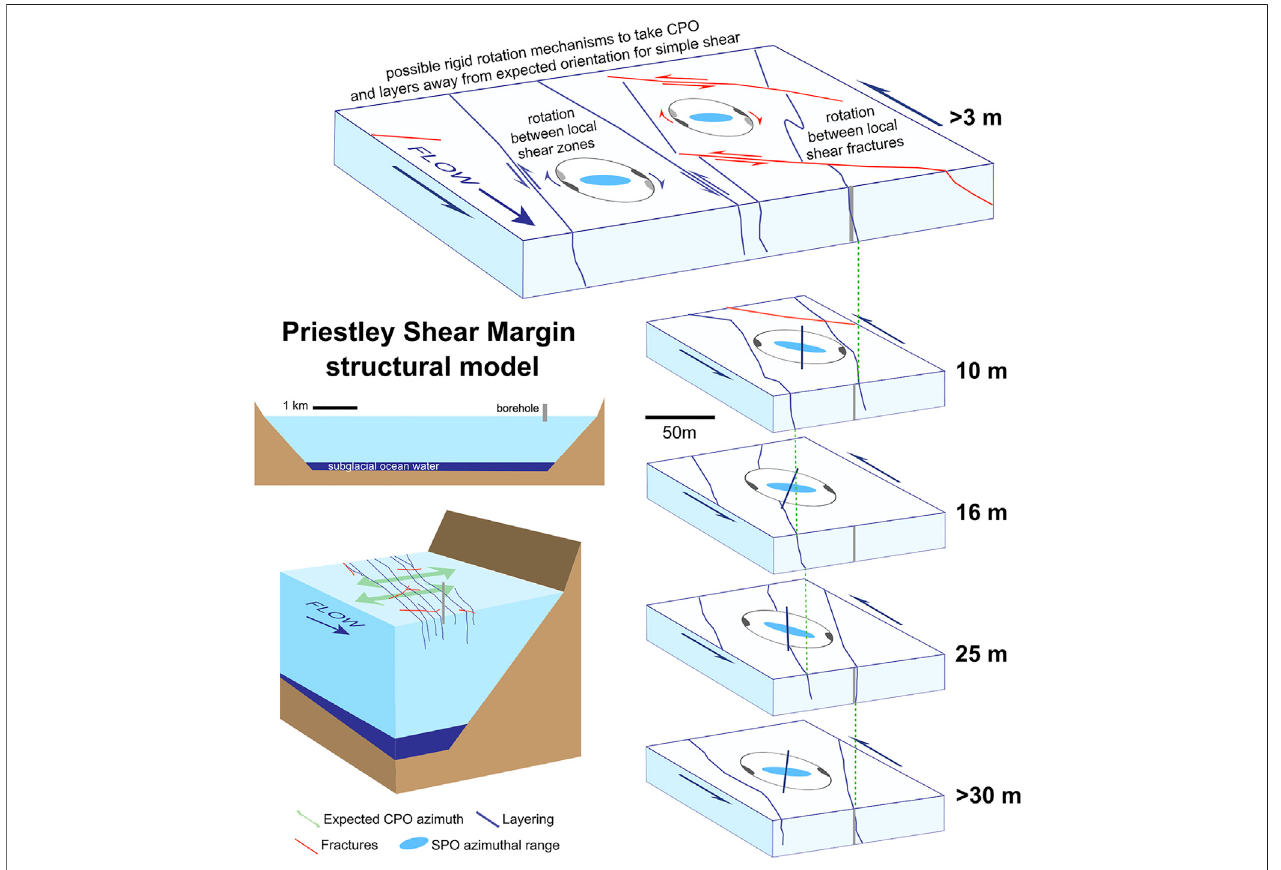
FIGURE14| Thekinematicsettingofthe fl oatingPriestleyGlacierlateralsinistralshearmarginasdeterminedbyGNSSpositioningdata, fi eldobservationsandcore CPO and microstructure. Oscillatory CPO and grain long axis rotations occur twice within the top 30 m of the core, with low degree, small scale rotations imposed by layers intersecting the core. Green dashed lines de fi ne near vertical layering extending to